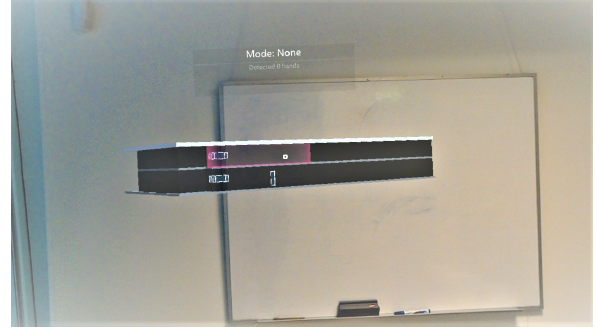
Figure 1. Showing the building miniature.